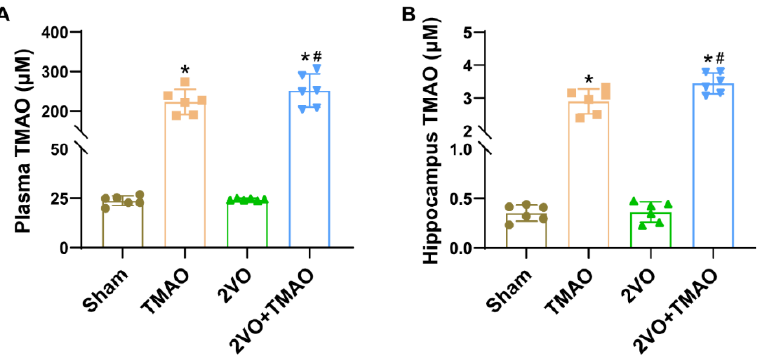
Figure 1. The levels of TMAO increased in TMAO-treated rats after 2VO surgery. TMAO levels in ( A ) plasma and ( B ) hippocampal tissue treated with TMAO before and 4 weeks after 2VO surgery (n = 6). The datasets reflect the mean ± SD. * p < 0.05 versus the Sham group; # p < 0.05 versus the 2VO